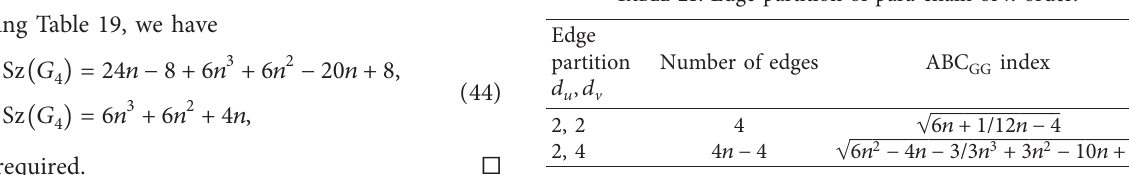
Table 21: Edge partition of para chain of n order.